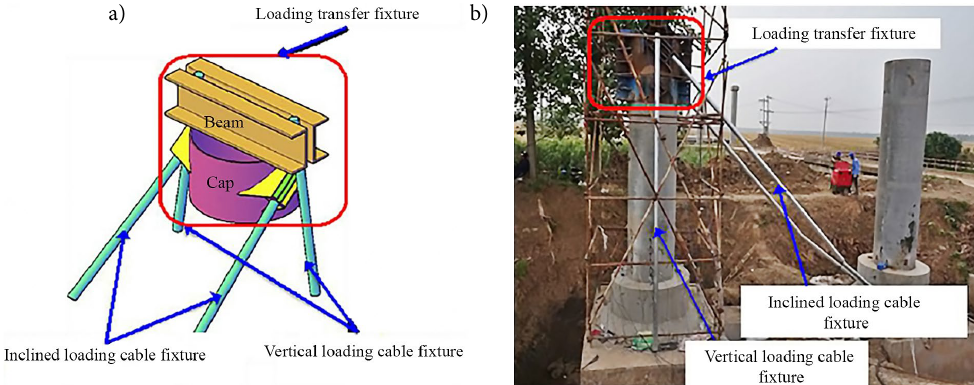
Figure 2. Test setup: a – Test set up composed of three loading fixtures; b – Photograph of loading